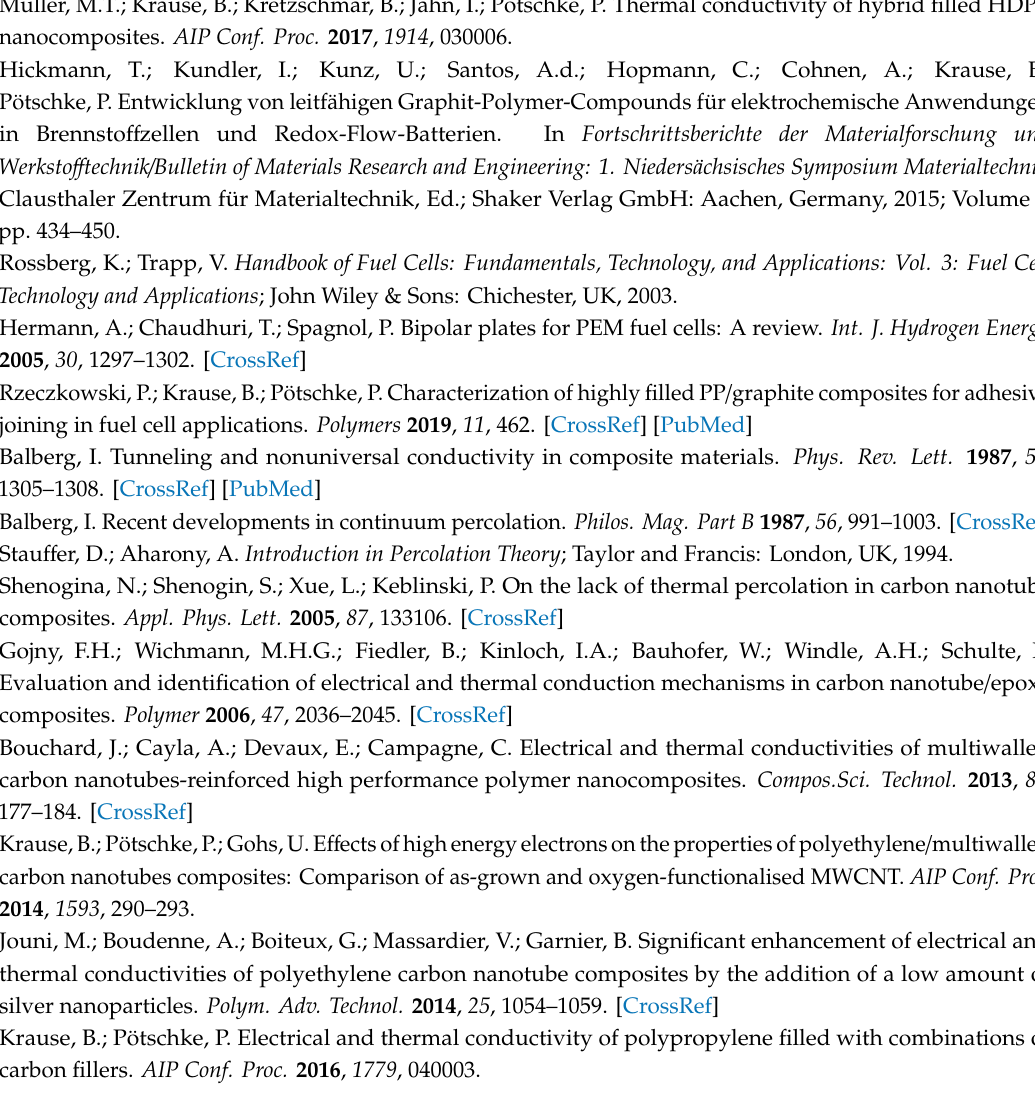
Table S1: Thermal conductivity and electrical volume resistivity of PP composites filled with di ff erent kind of carbon black at a filler content of 5 vol%; Table S2: Thermal conductivity and electrical volume resistivity of PP composites filled with di ff erent kinds of expanded graphite at a filler content of 5 vol%; Table S3: Thermal conductivity and electrical volume resistivity of PP composites filled with di ff erent kinds of graphite at a filler content of 5